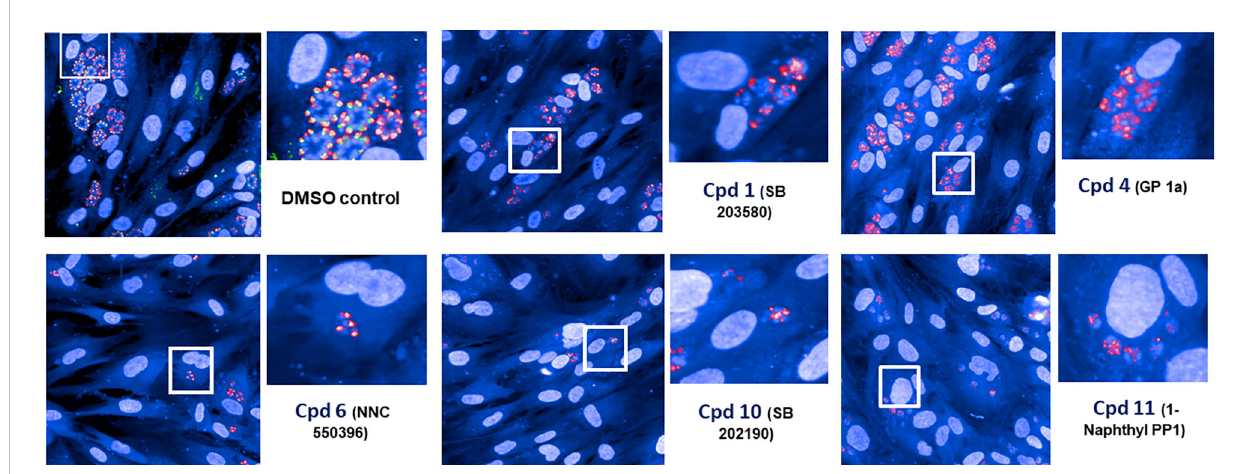
FIGURE 7 Screening hits. Five hits were obtained using our automatic image-based screening protocol and these fl uorescence images (featuring necrotized intracellular parasites) illustrate the disruption of classical apical location of ROP1 signal compared to the negative DMSO control that shows intracellular dividing tachyzoites with normal morphology.